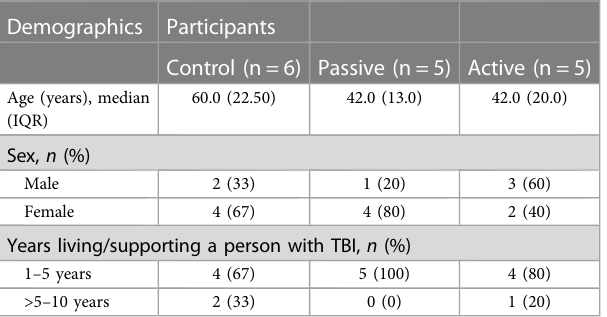
TABLE 1 Demographic characteristics of the